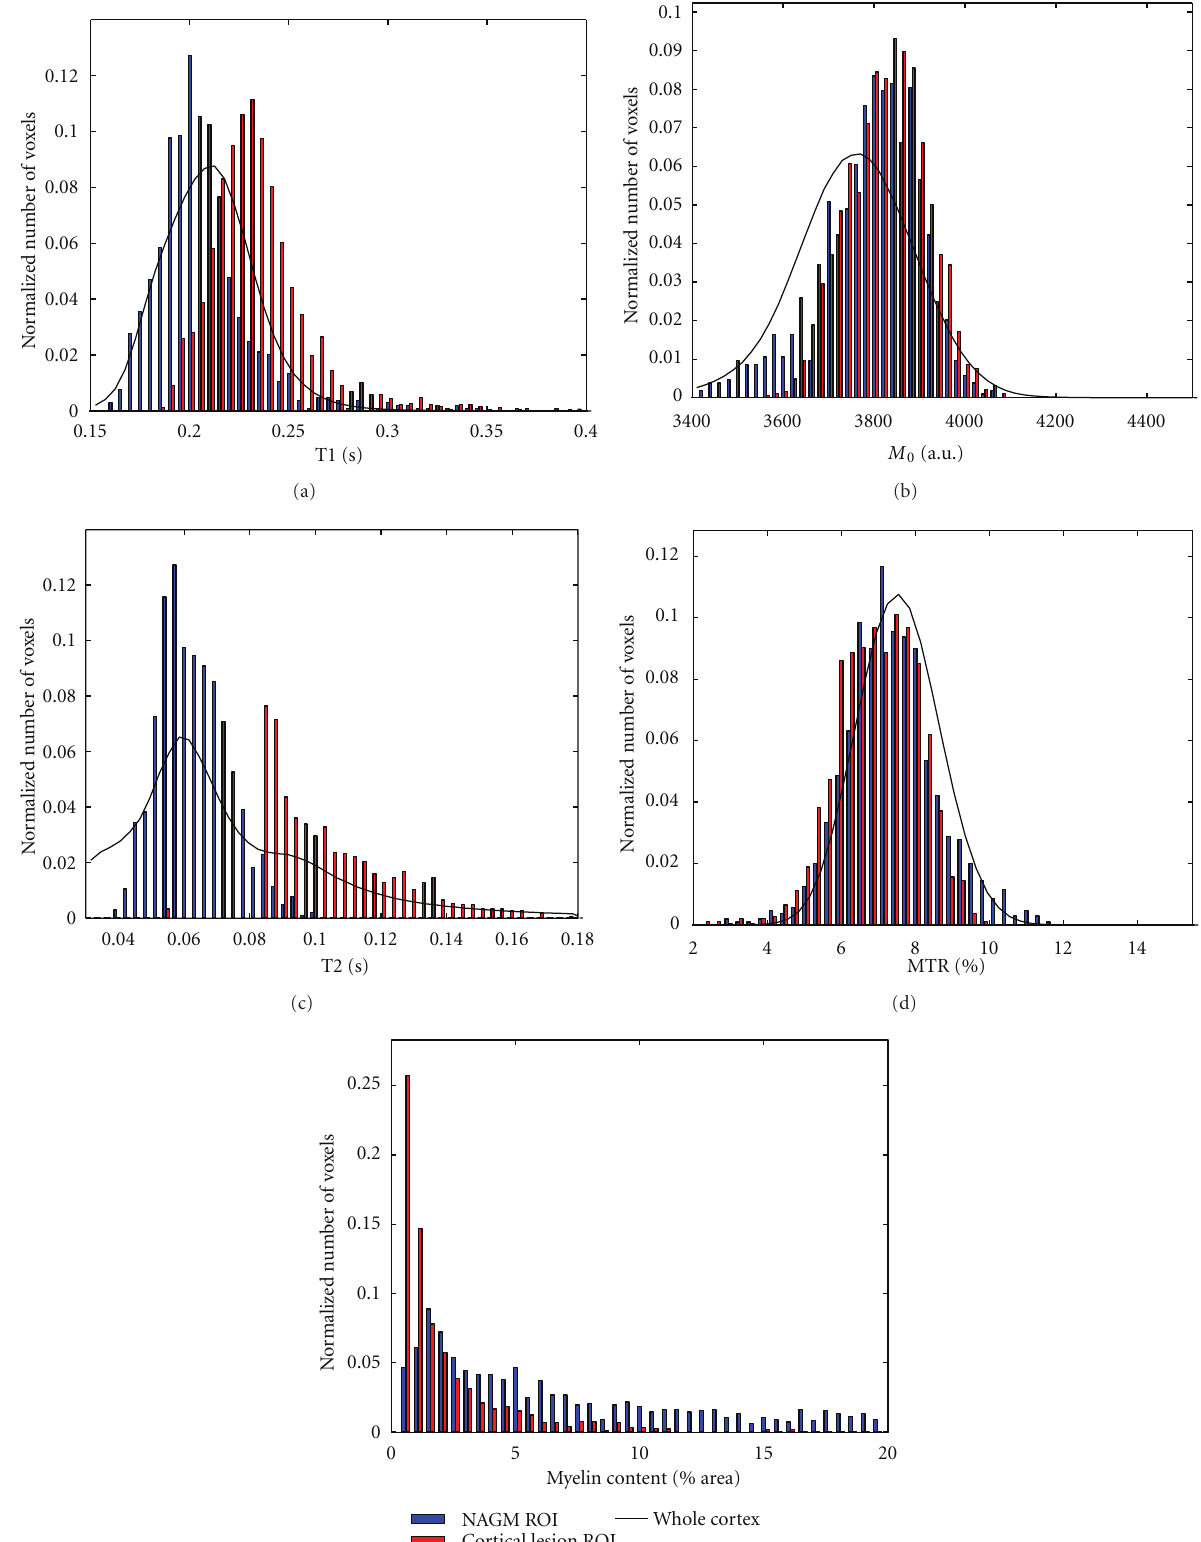
Figure 8: Histograms of the qMR parameters and myelin content where blue corresponds to voxels labeled NAC, red to CL, and the black line to the distribution over the entire